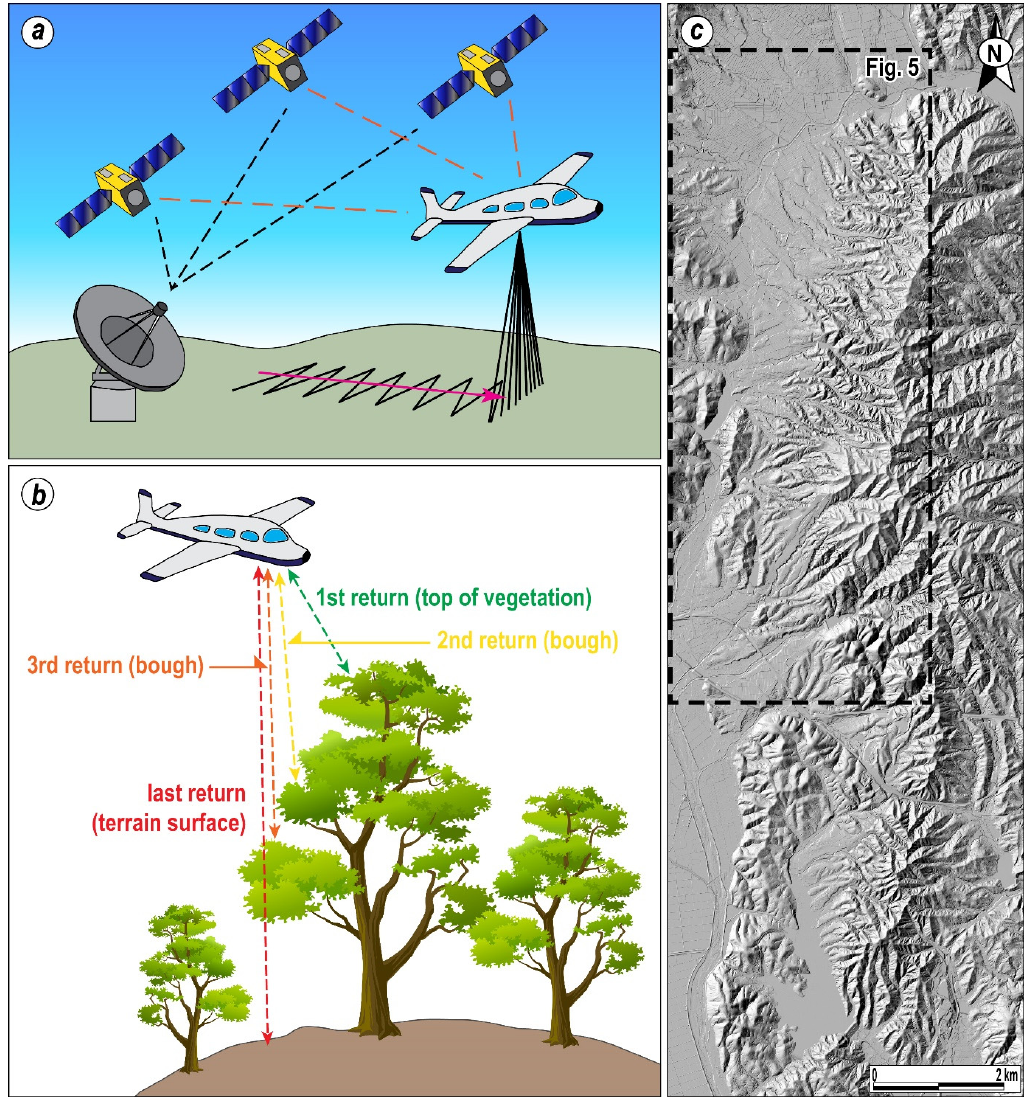
Figure 4. Schematic diagrams showing the LiDAR imaging principles. ( a ) Airborne LiDAR imaging systems. ( b ) Laser point 3D surface information. ( c ) Airborne LiDAR imaging hillshade.